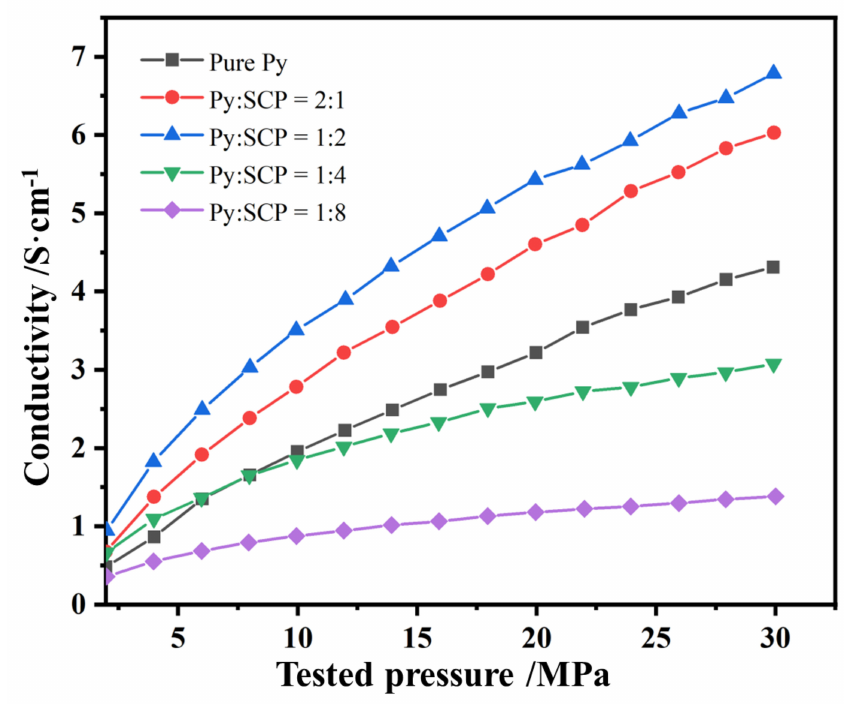
Figure 3. The conductivity of PPy/SCP particles with the mass ratios 2:1, 1:2, 1:4 and